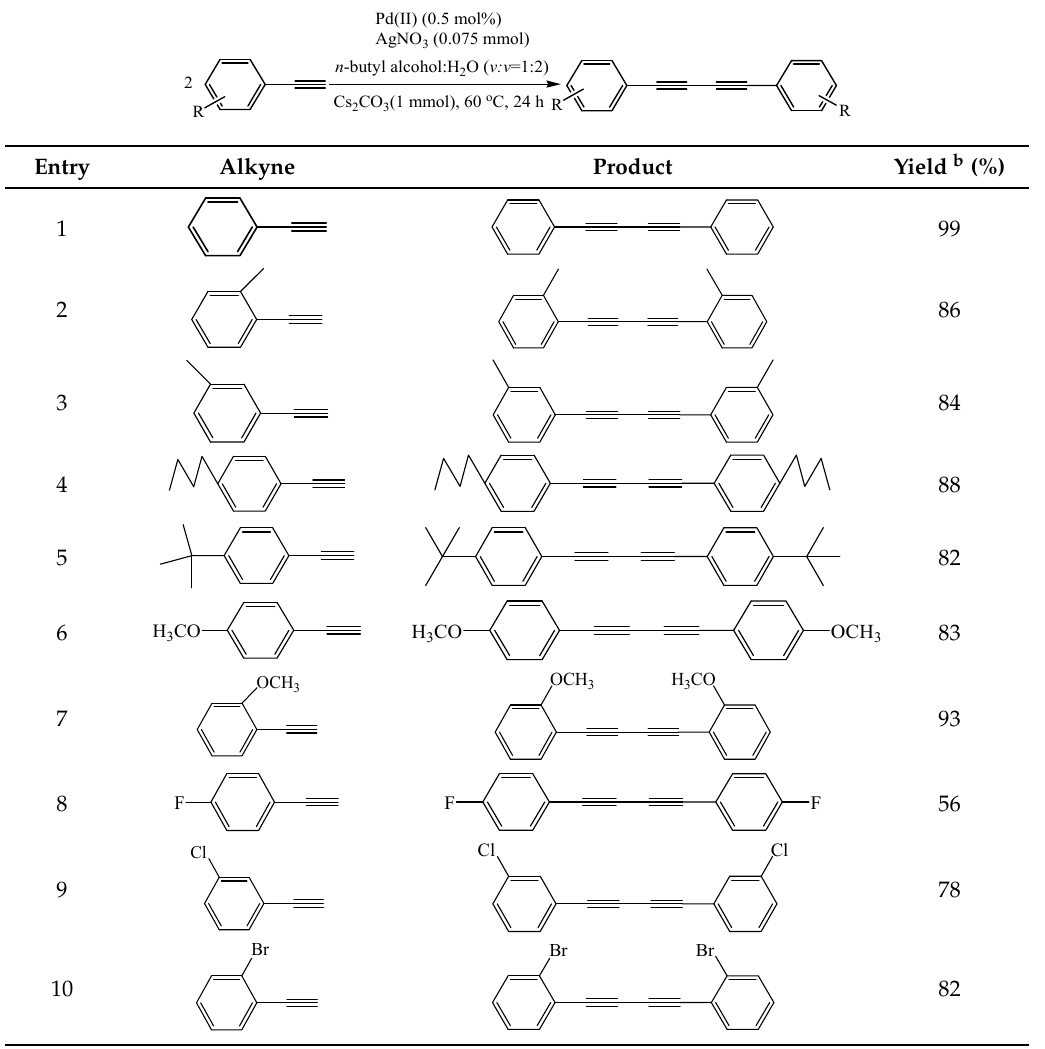
Table 3. Pd(II)/AgNO 3 -catalyzed the homocoupling reactions of aromatic terminal alkynes a .